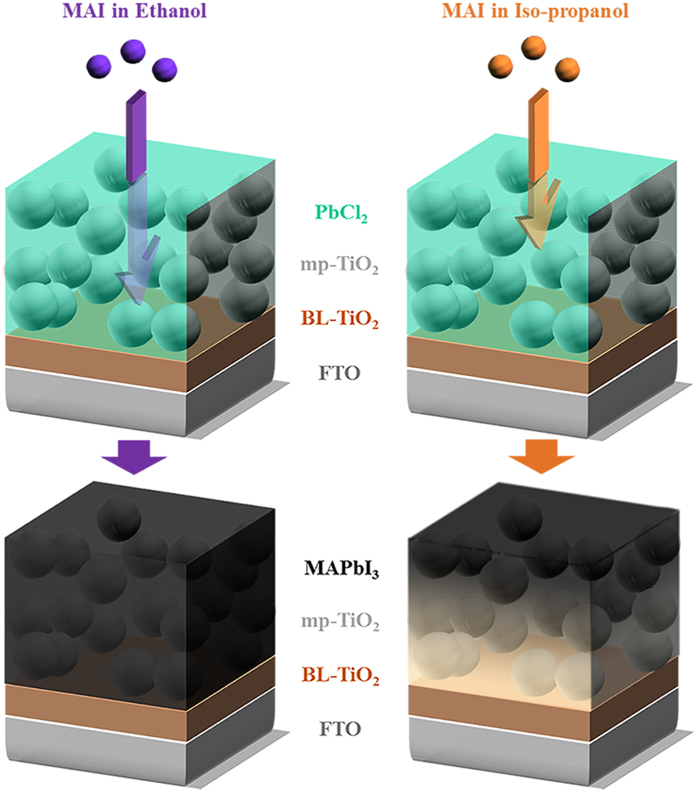
Schematic illustration of the MAI in ethanol or iso-propanol diffusing into the PbCl2-wetted mesoporous-TiO2 (mp-TiO2).The blocking-layer is coated on SnO2:F (FTO).